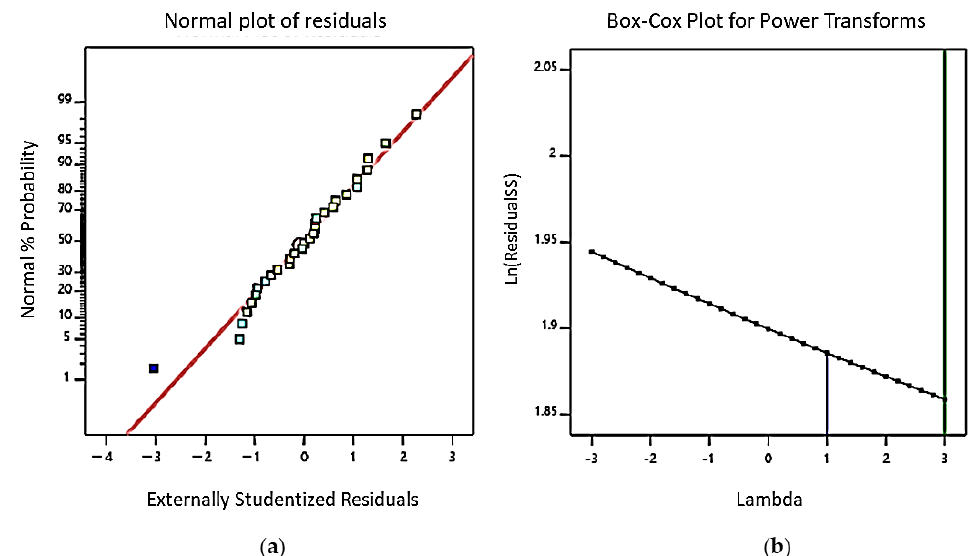
Figure 2. ( a ) Normal plot of residuals; ( b ) Box – Cox plot. Table 2. Analysis of variance results for the experimental design.